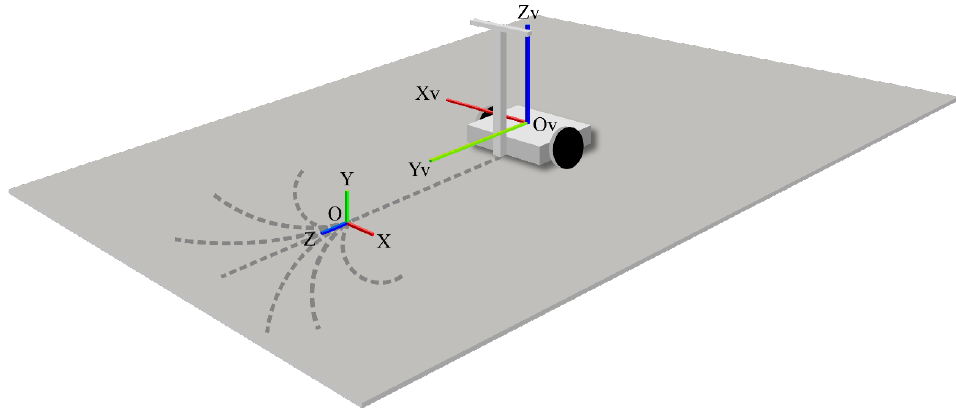
Figure 17. Vehicle coordinate system.